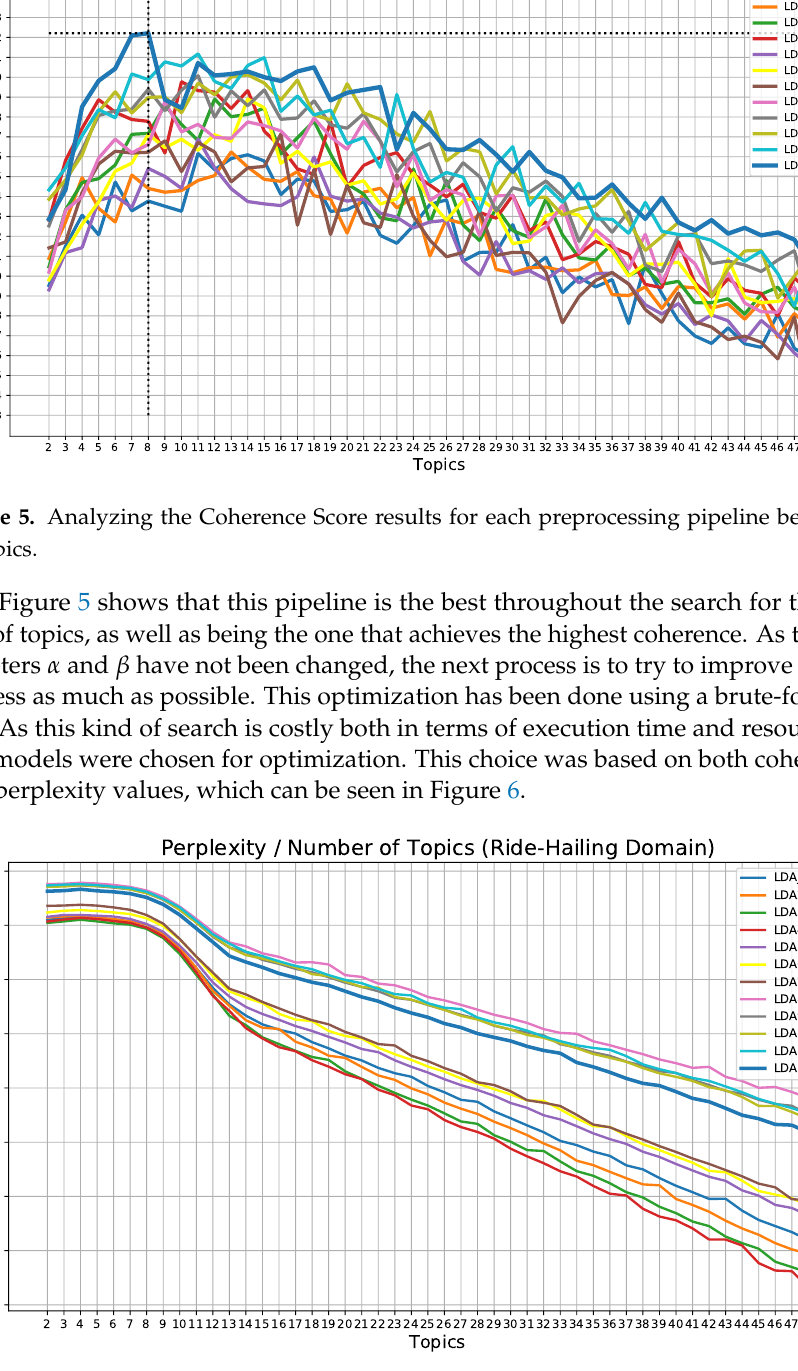
Figure 6. Analyzing the perplexity results for each preprocessing pipeline between 2 and 50